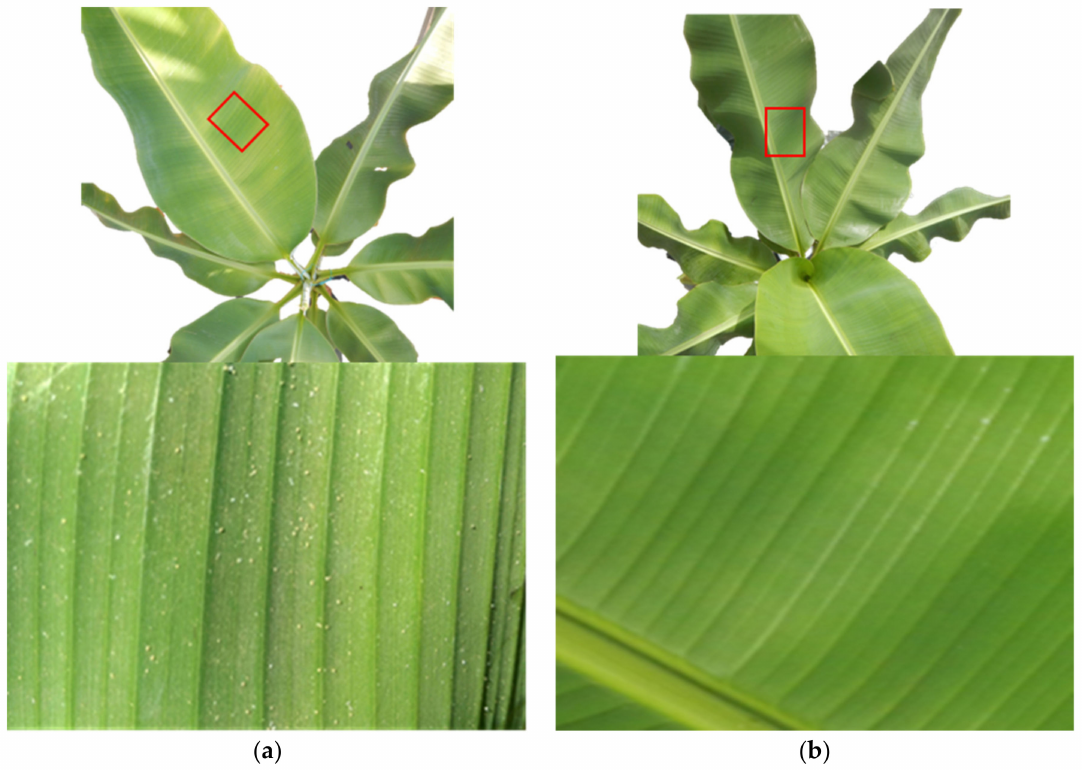
Figure 1. Example of mite infestation and damage to banana plant leaf ( a ) and a healthy banana plant leaf ( b ) red insets provide indicative areas of interest for each